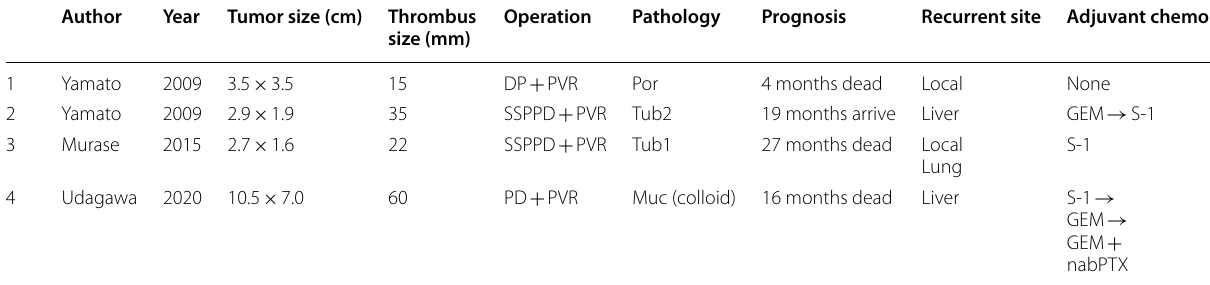
Table 1 Cases of pancreatic ductal carcinoma with portal vein tumor thrombus